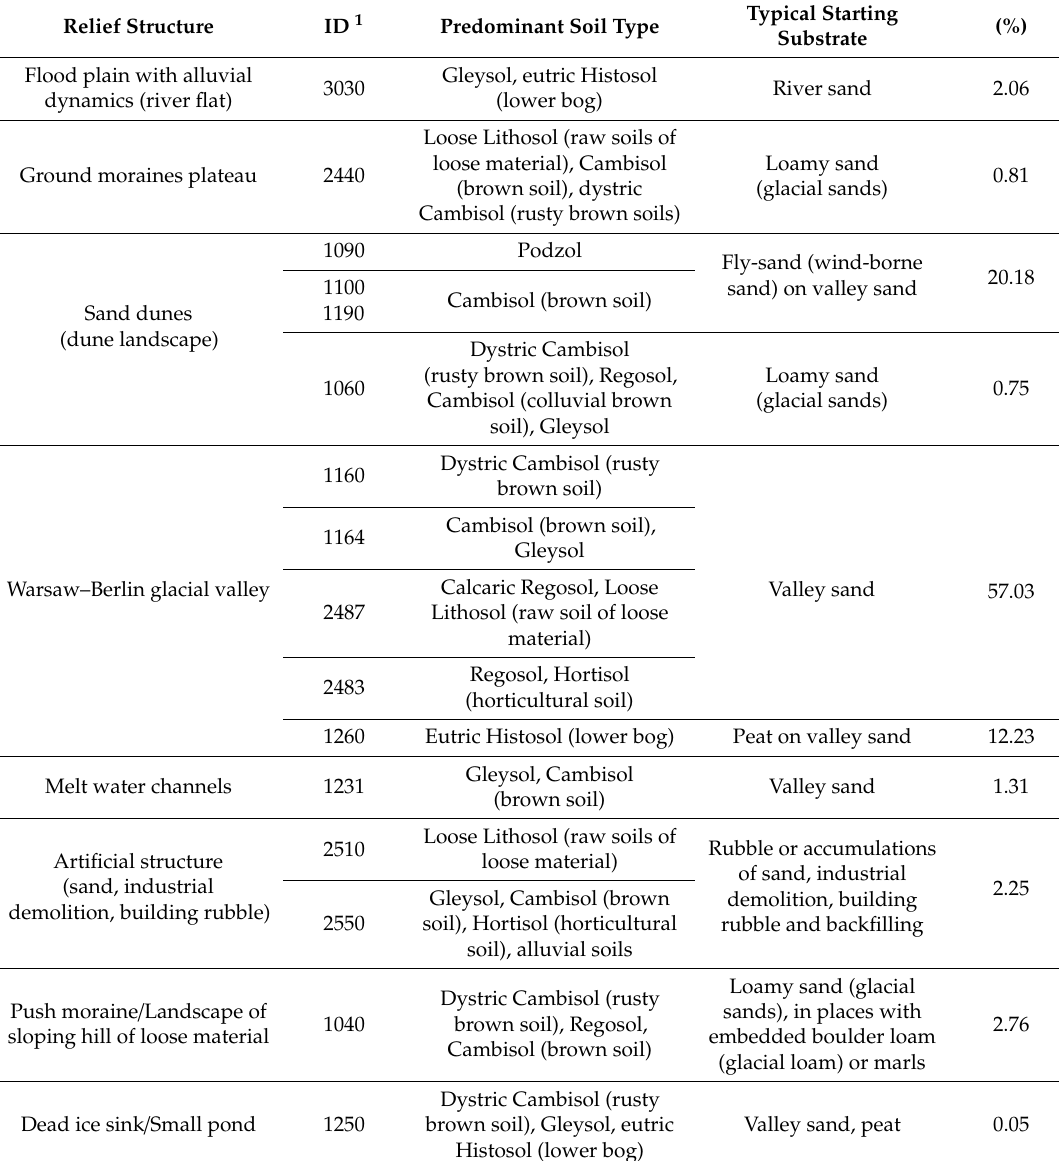
Table 1. Relation of relief, substrate and soil types in the investigation area